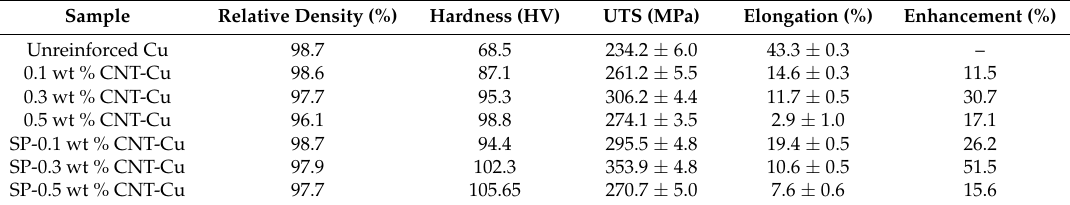
Figure 6. Stress-strain curves of unreinforced Cu, CNT-Cu composites and SP-CNT-Cu composites with different CNT content, respectively. Table 1. Comparison of tensile properties of composites prepared in this work.